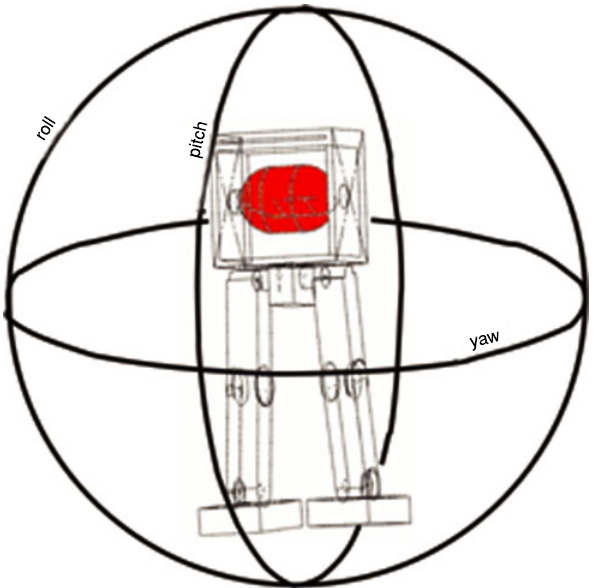
Figure 4 Design of a (hypothetical) robot. The simulated robot has 3 degrees of freedom in each leg plus the degree of freedom due to the rotor.